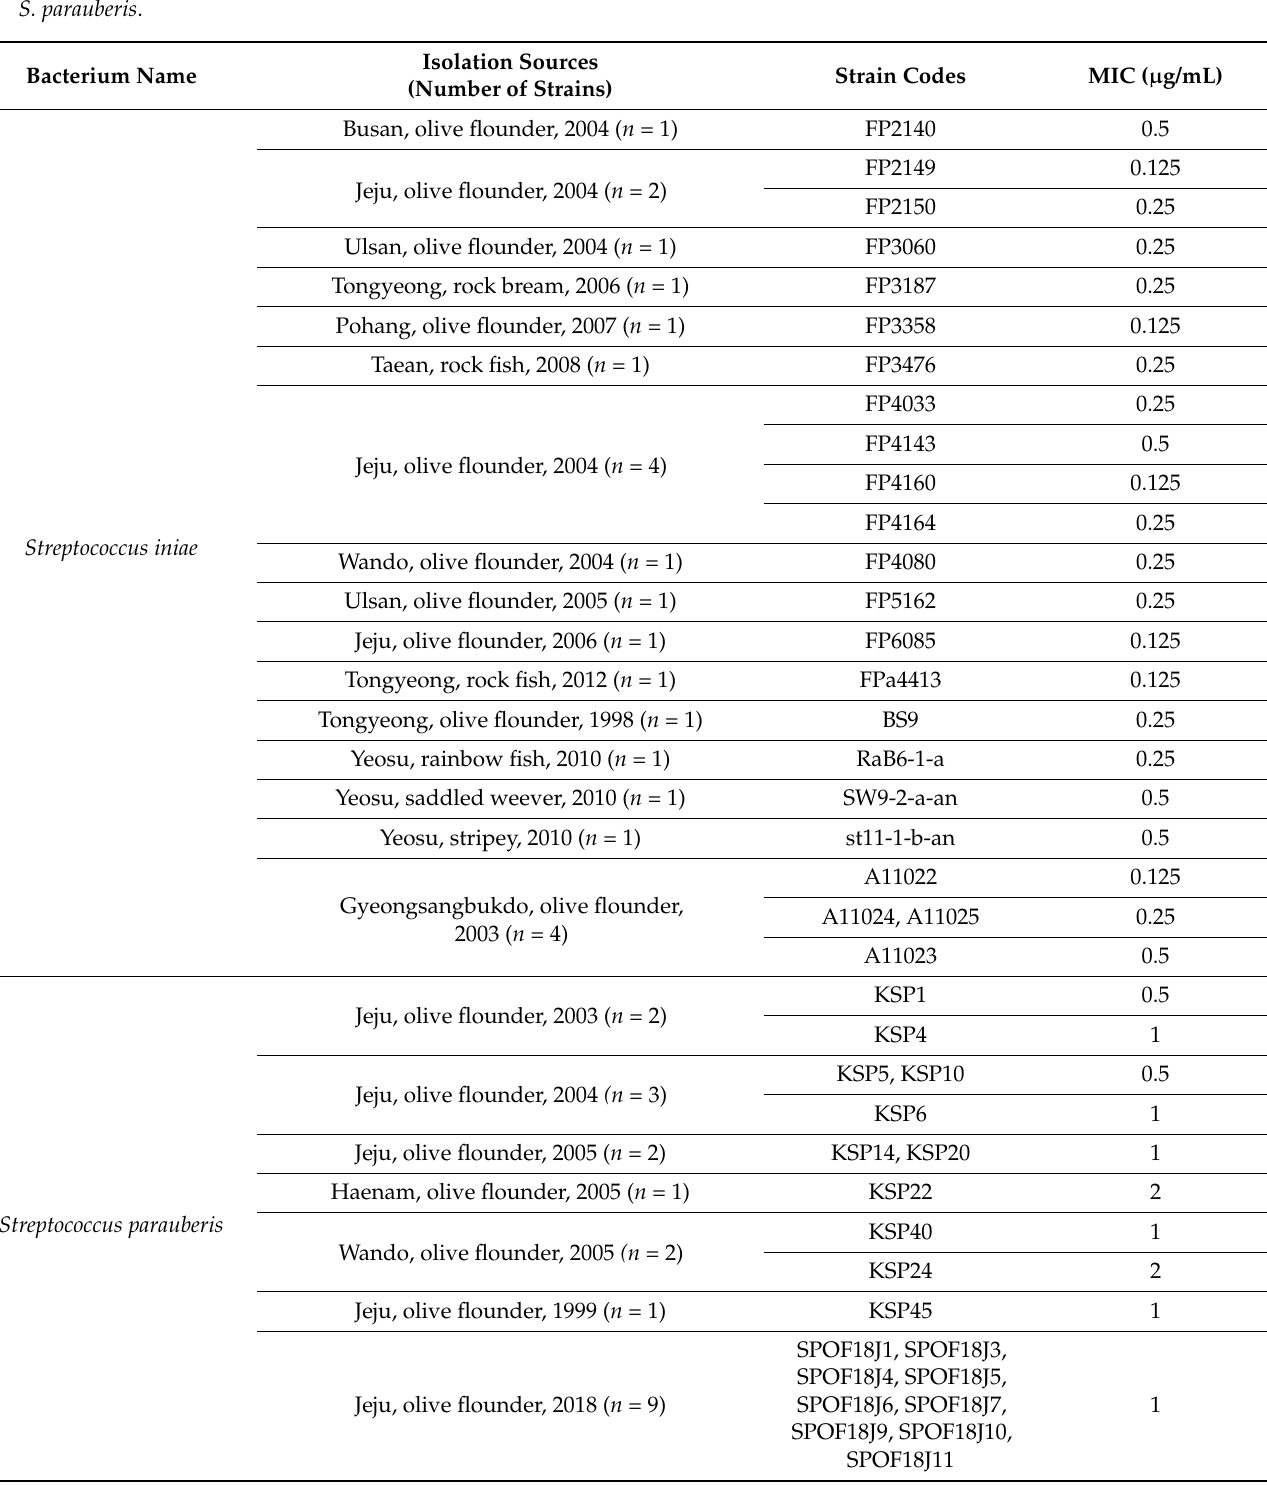
Table 3. In vitro antibacterial activity minimum inhibitory concentrations (MICs) tylosin tartrate against S. iniae and S. parauberis